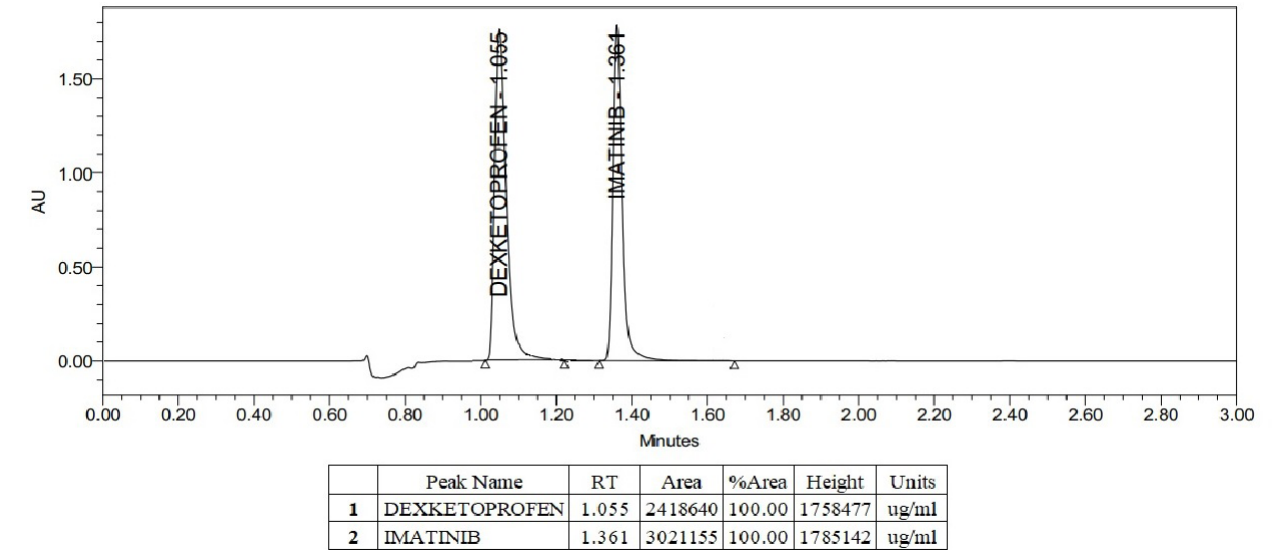
FIGURE 6 - UPLC chromatogram of dexketoprofen trometamol and imatinib mesylate in distilled